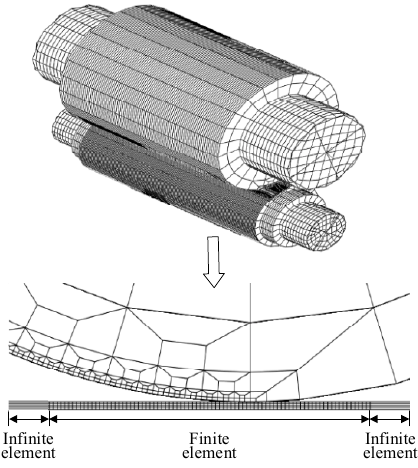
Figure 8. Improved rolls-strip coupling model based on FE-IE coupling